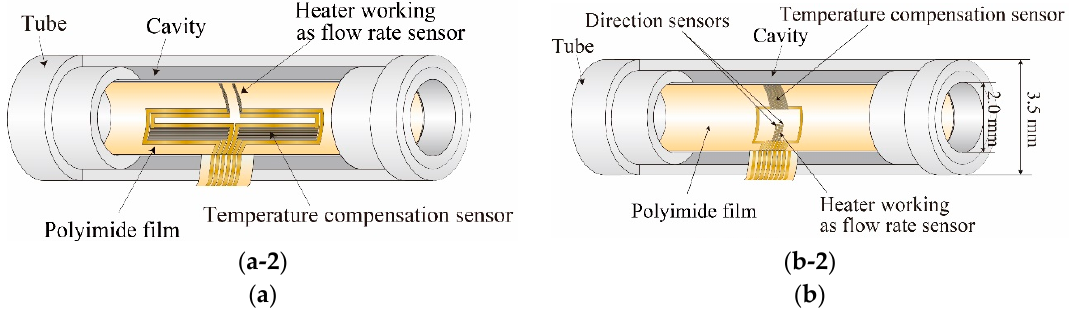
Figure 3. Tube flow sensor for detecting both flow rate and flow directions: ( a ) Previous sensor; ( a-1 ) design of sensor elements; ( a-2 ) schematic view; ( b ) Proposed sensor; ( b-1 ) design of sensor elements; ( b-2 ) schematic view.